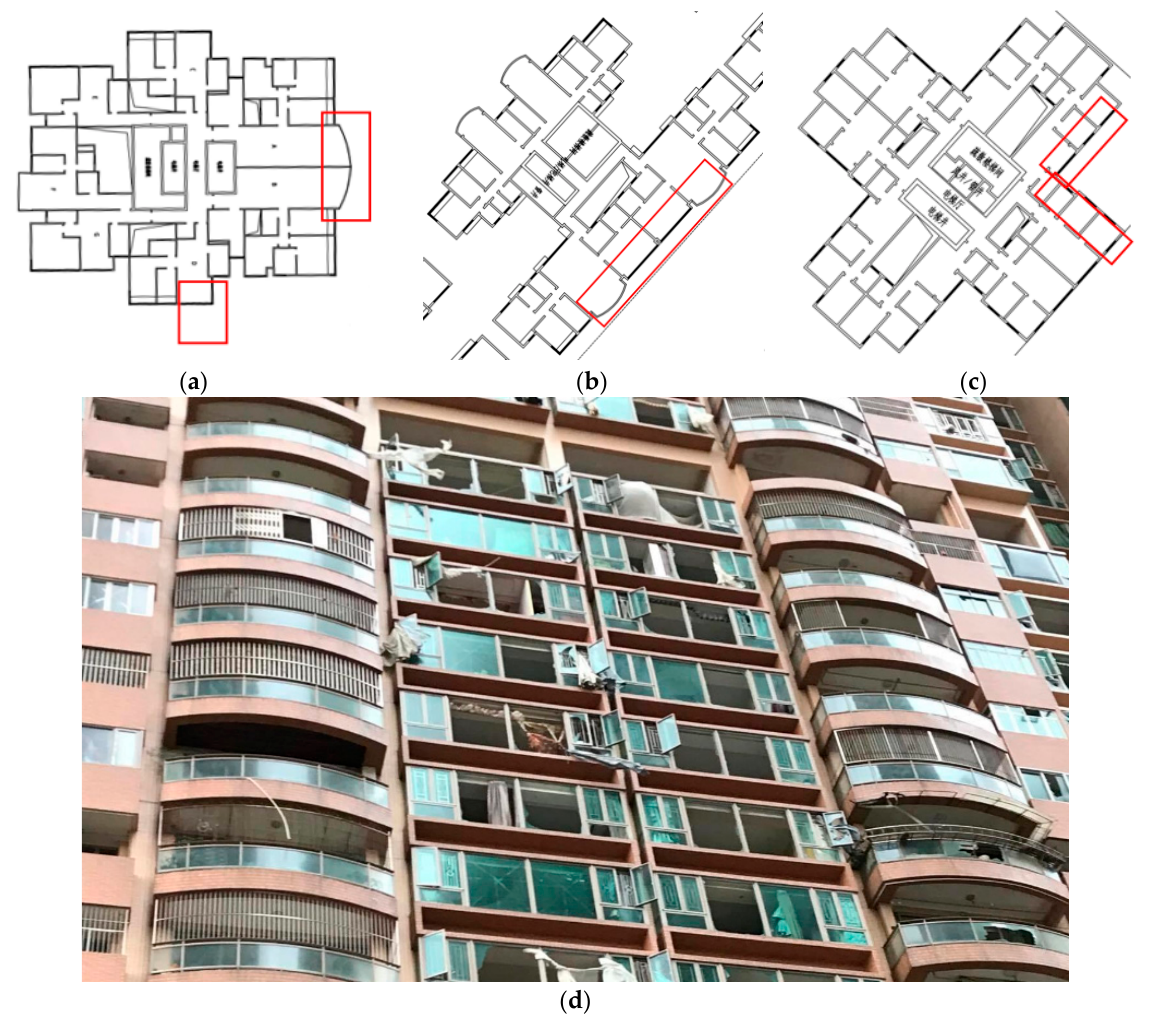
Figure 10. Locations vulnerable to typhoon damage in the standard layer plane. ( a ) Villa de Mer standard floor; ( b ) La Baie du Noble standard floor; ( c ) EDF. Polytec Garden standard floor; and ( d ) Damage to the facade windows of La Baie du Noble after Typhoon Hato. In the floor plan ( a – c ), the Chinese text indicates the location of the elevator room of the